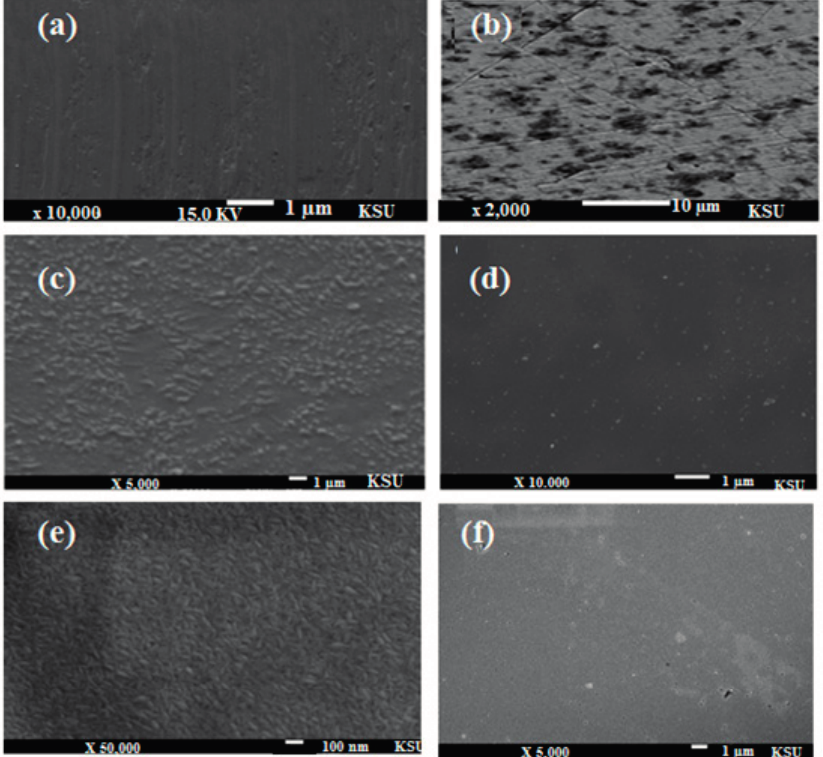
Figure 13. SEM micrographs of ( a ) polished steel bare; ( b ) steel bare immersed in 1 M HCl; ( c ) steel coated with 100 ppm of OA-TS; ( d ) steel coated with 100 ppm of OA-TS after immersion in 1 M HCl; ( e ) steel coated with 100 ppm of ODA-TS before immersion in 1 M HCl and ( f ) steel coated with 100 ppm of ODA-TS after immersion in 1 M